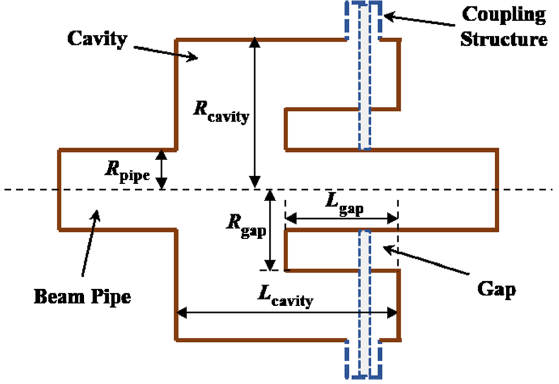
FIG. 2. Schematic cross section of the cavity. In the R=Q optimization process, the cavity is built without the coupling structure (the blue dotted line).